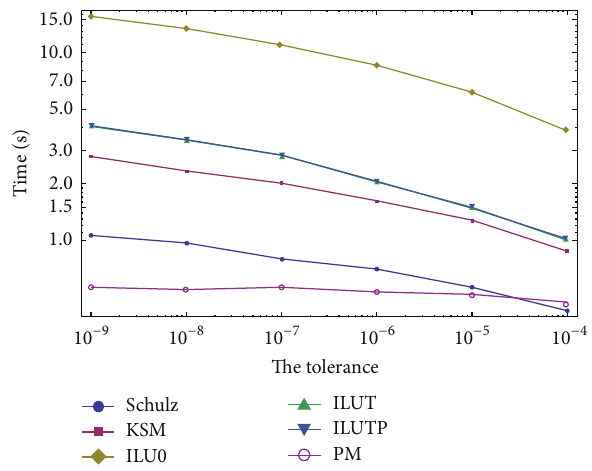
Figure 5: Comparison of the computational times for various preconditioners in Experiment